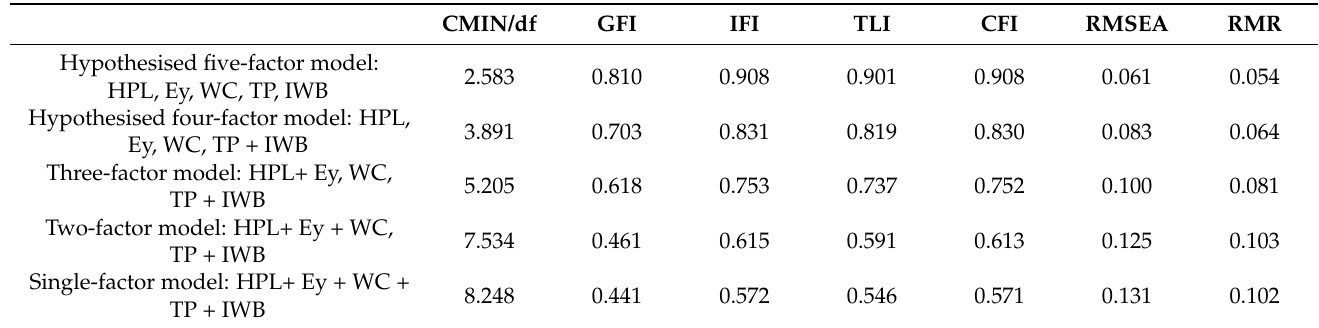
Table 1. Model fit.